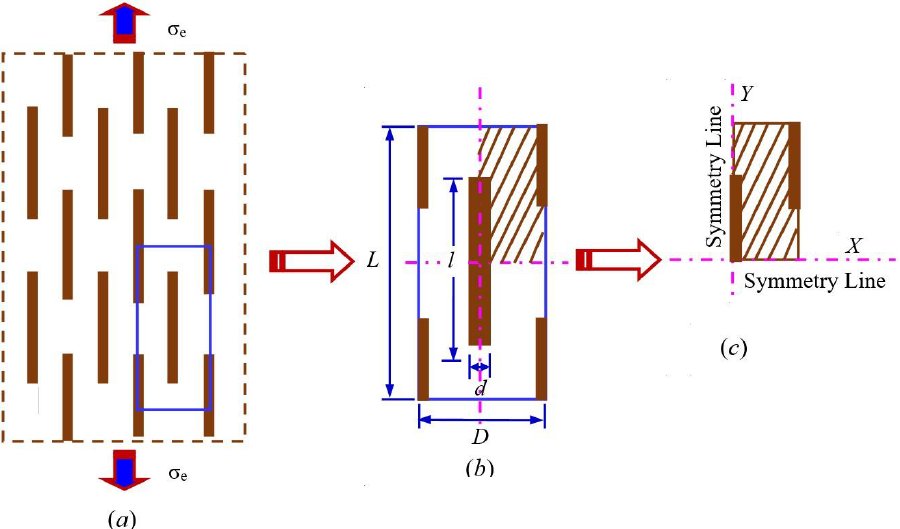
Figure 6. Representative volume element (RVE) of a PNC reinforced with aligned, identical clay nanoparticles in a stagger distribution configuration. ( a ) Idealized identical staggering clay platelets; ( b ) a typical RVE; and ( c ) a quarter RVE for efficient simulation.